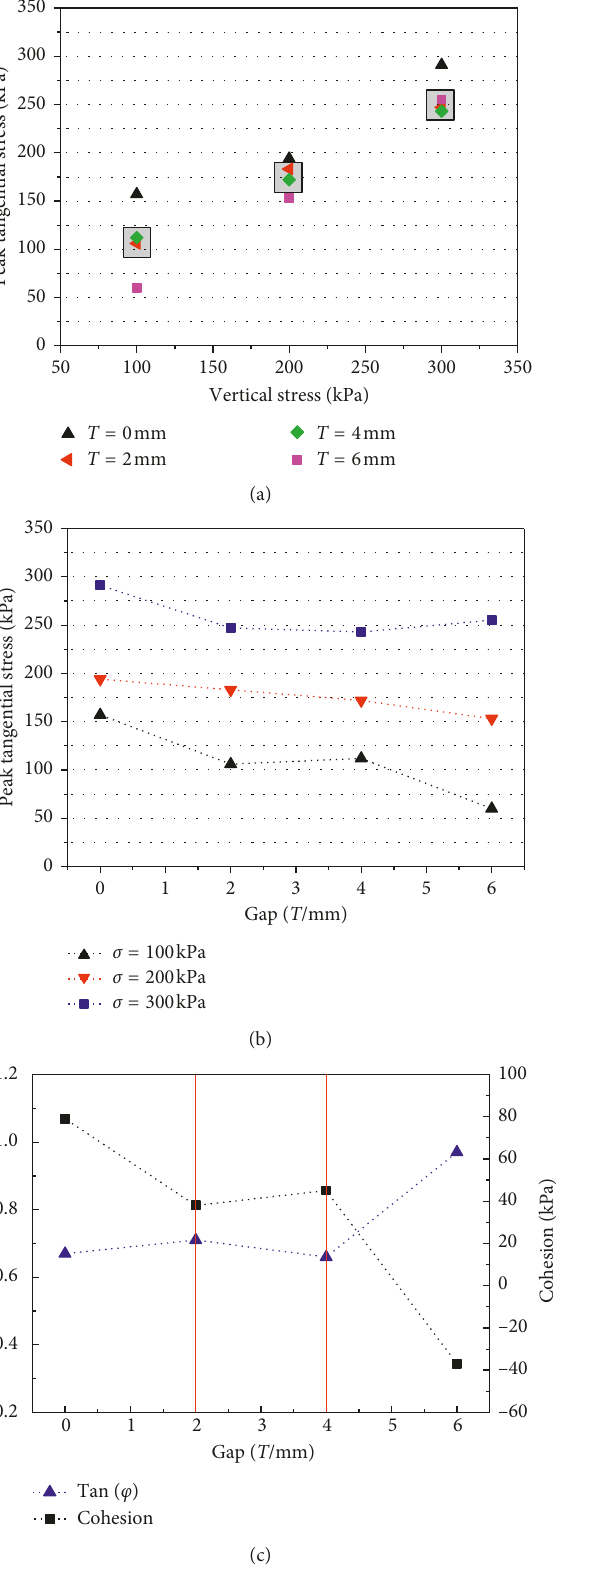
Figure 7: (a–c) Gap effect on the tangential properties of S-RM (shear box, R � 200mm and H � 300mm).